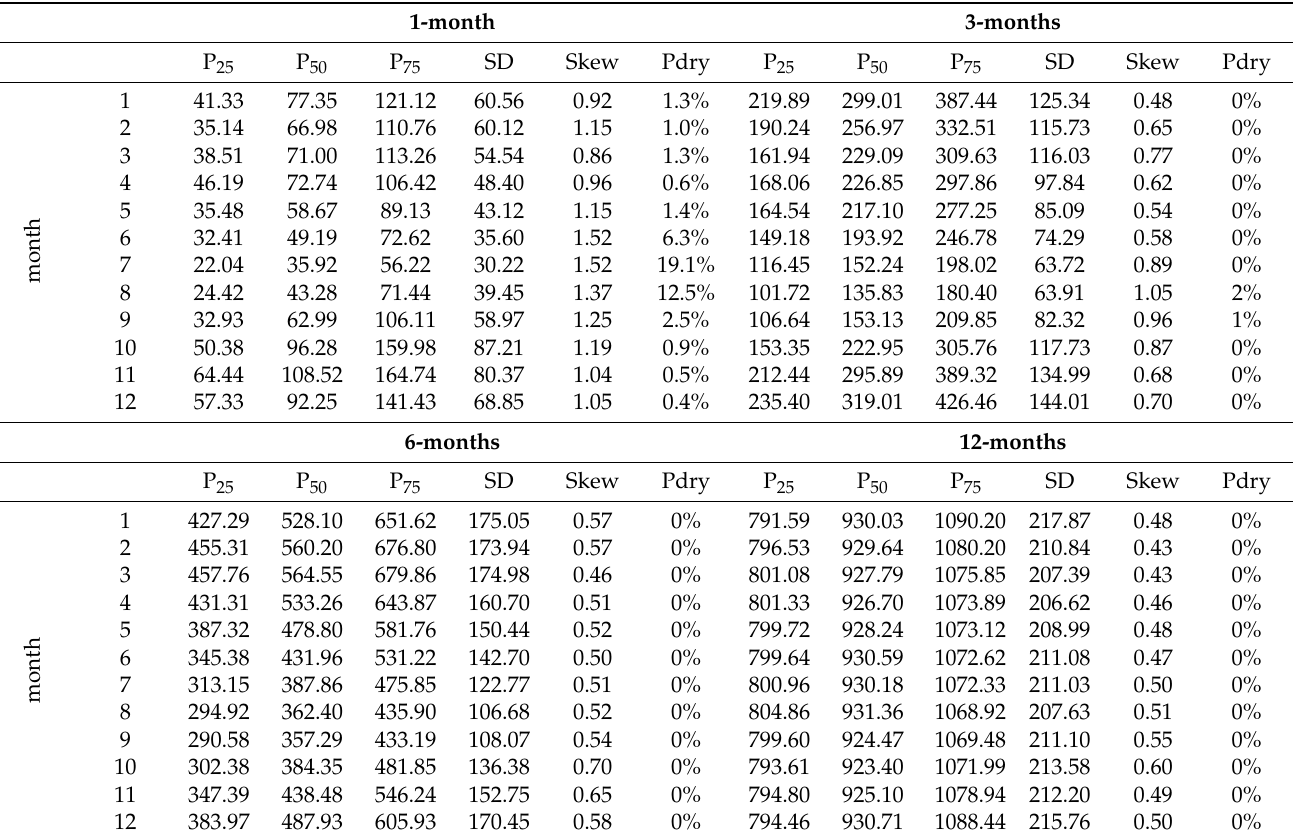
Table 2. Mean values of the main statistics evaluated on the 332 samples for each k − th time scale (1, 3, 6 and 12 months) and for each j − th month. Apart from the probability dry (P dry ), these statistics are evaluated considering the non-zero monthly